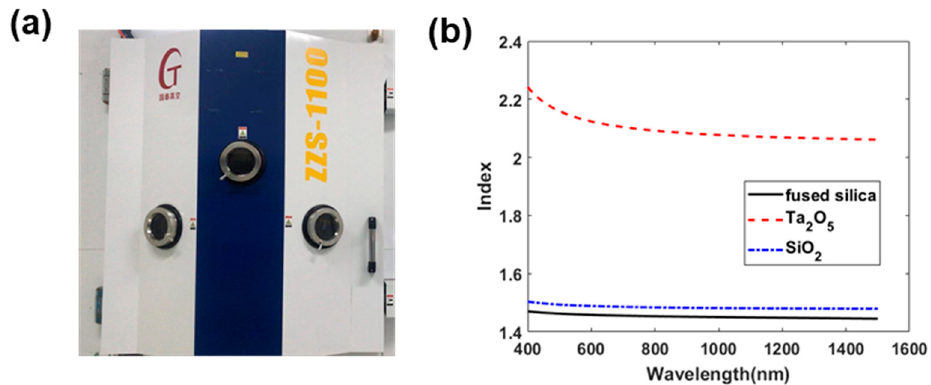
Figure 6. ( a ) The ion-beam-assisted coating system and ( b ) the indices of the materials used in the thin-film growth.